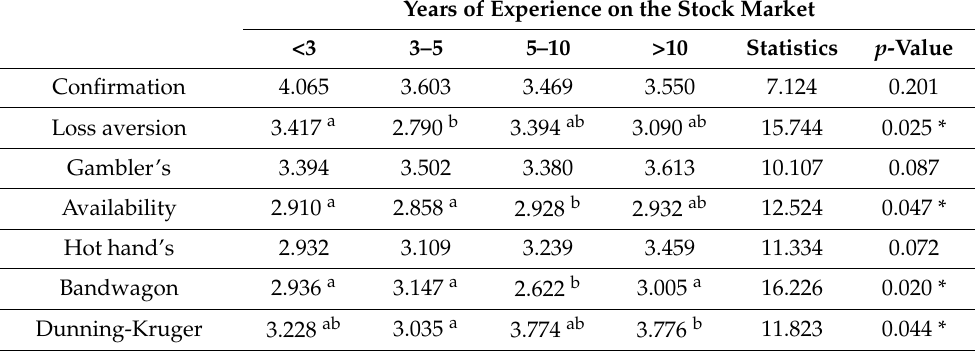
Table 4. Fallacies based on years of experience on the stock